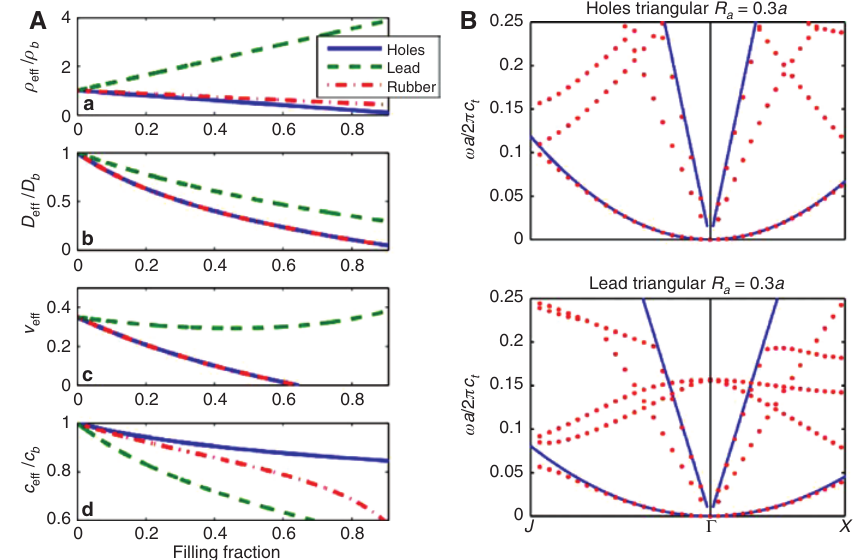
Figure 2: Effective elastic parameters of phononic crystal plates. (A) The effective mass density (a), rigidity (b), Poisson’s ratio (c) and phase velocity (d) with respect to the filling fraction for different cylinder inclusions in an aluminum plate [61]; (B) Dispersion relations for a phononic crystal plate made of a triangular lattice of circular holes and lead inclusions with a radius of 0.3 a . The red dots show the band structures obtained by the finite element method, while the blue lines show the dispersion curves calculated with homogenized parameters from Eq. (10)